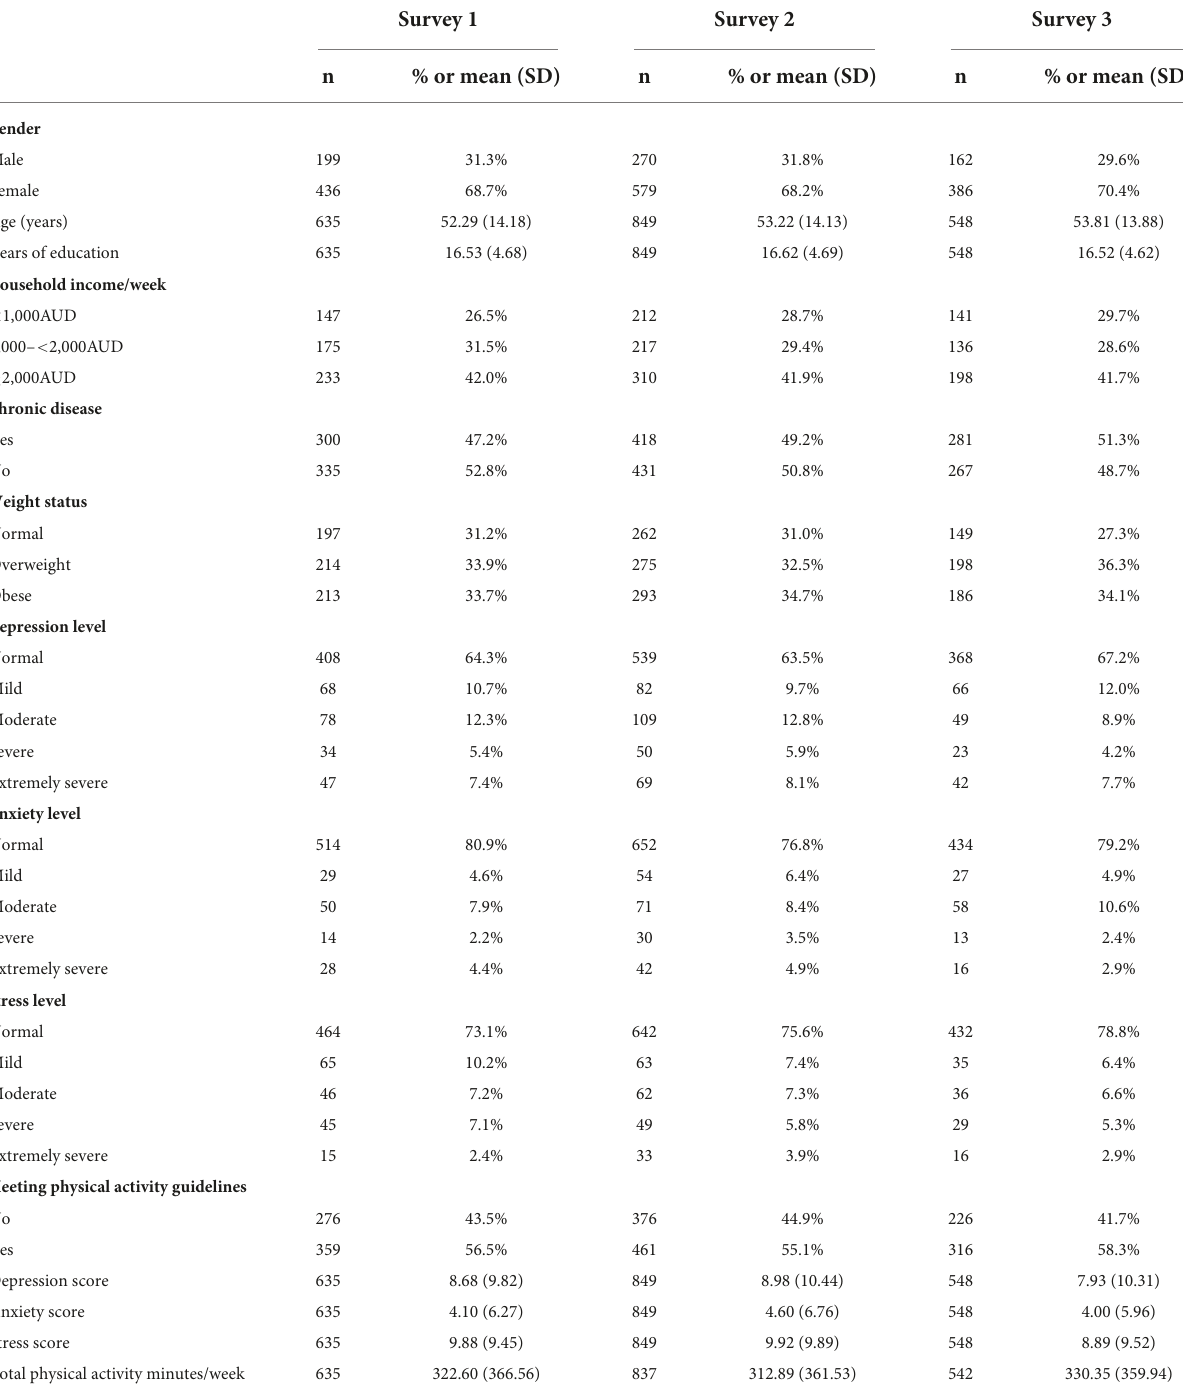
TABLE 1 Sociodemographic characteristics of the longitudinal